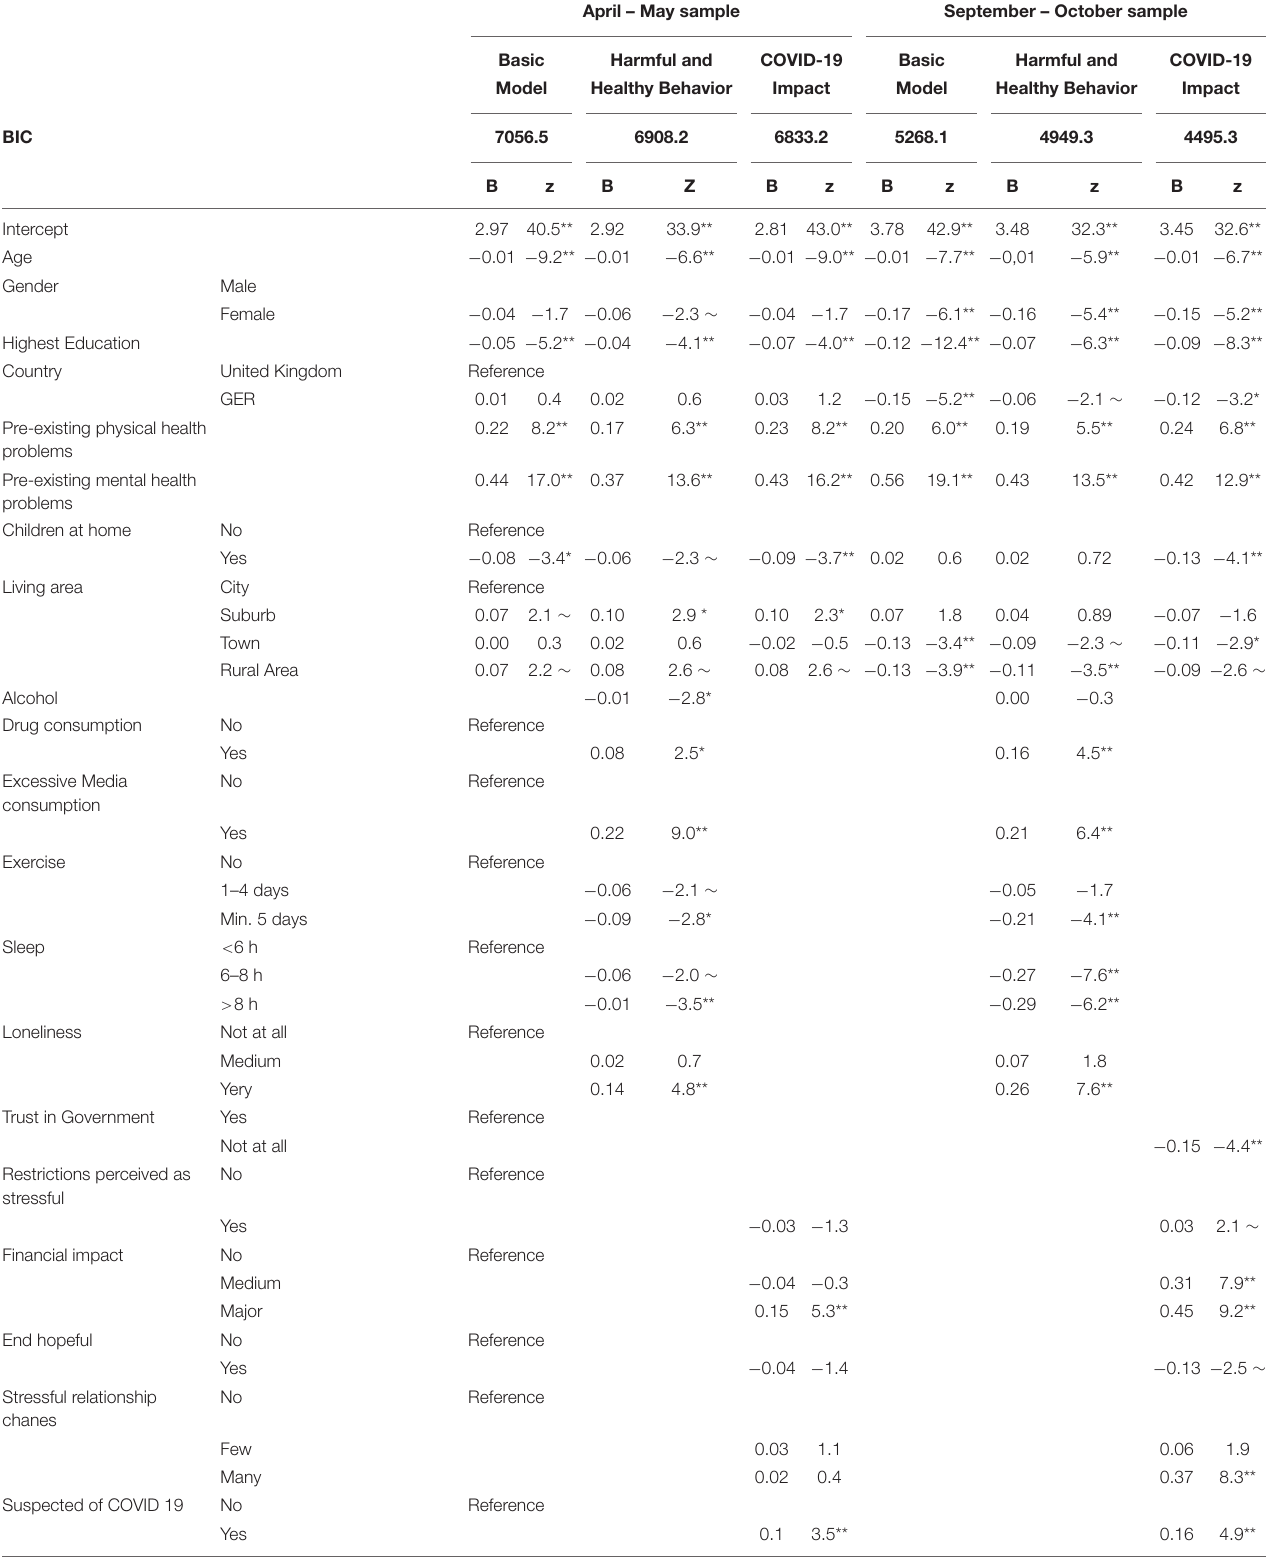
TABLE 4 | Overview over all three conducted models (Basic Model, Harmful and Healthy Behavior, COVID-19 Impact) for both samples for SPQ